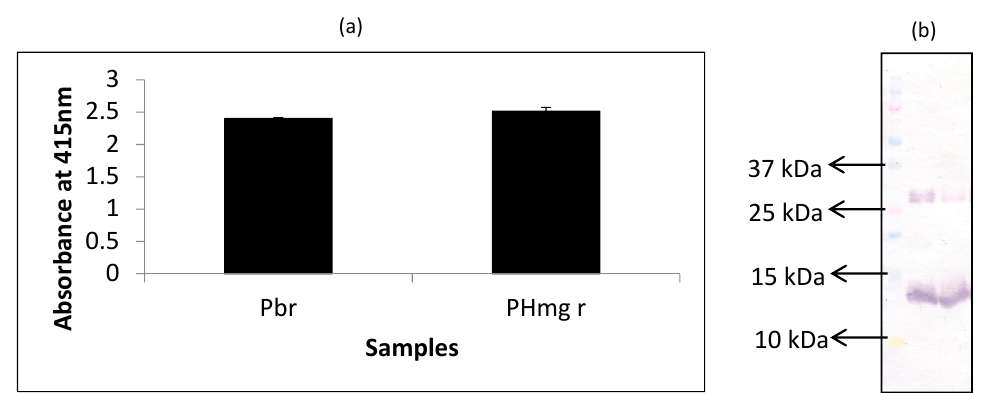
Figure 1. Analysis of raw porcine blood (Pbr) and porcine hemoglobin extracts (PHmg) using ( a ) iELISA and ( b ) western blot using mAb 24C12-E7 as probe. Samples were coated at 0.5 μ g per 100 μ L of carbonate buffer in iELISA. mAb 24C12-E7 supernatant was diluted 1:50 in 0.2% fish gelatin in PBST and iELISA results are expressed as A 415 ± SD, n = 3 (SD = standard deviation). In the case of western blot samples were loaded at 10 μ g per 10 μ L of sample buffer alongside the Precision Plus Protein Kaleidoscope pre-stained standards.